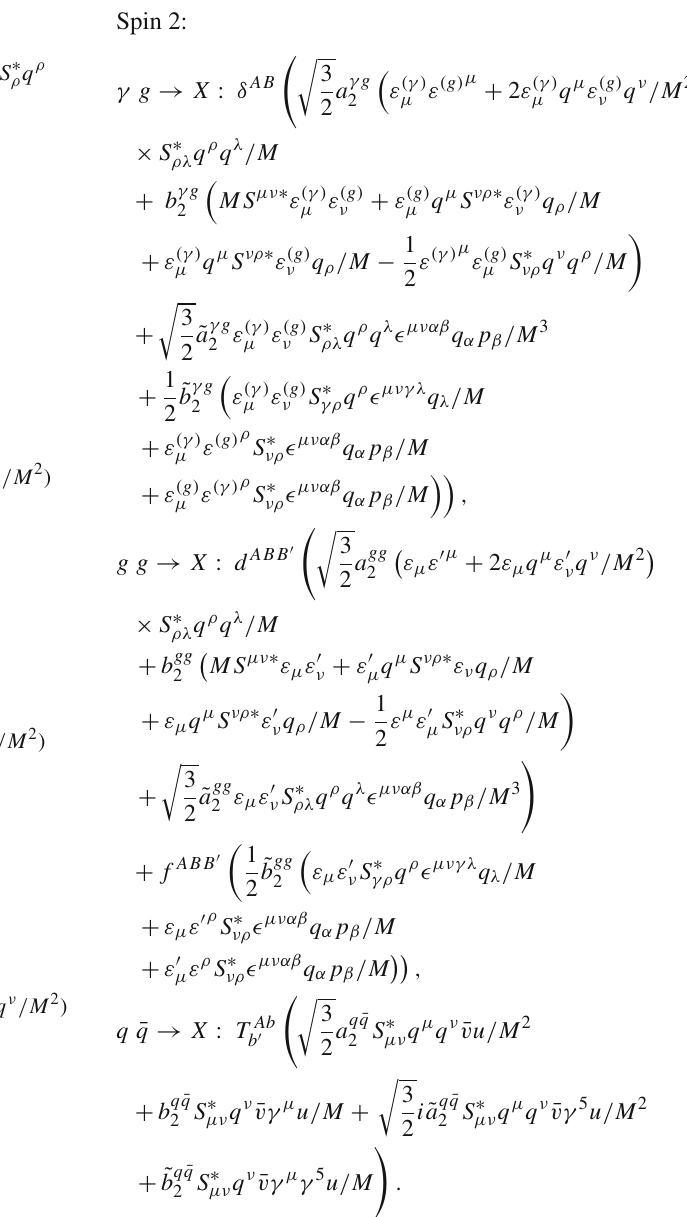
The amplitudes involving two incoming gluons respect Bose symmetry under the exchange: B ↔ B (cid:3) , ε ↔ ε (cid:3) , q ↔ − q . It is then straightforward to write down the non-zero pro- duction amplitudes out (cid:8) X , m | P , λ ; P (cid:3) , λ (cid:3) (cid:9) in for the process where parton P with helicity λ coming along the positive ˆ z axis ( θ = 0) and parton P (cid:3) with helicity λ (cid:3) coming along the negative ˆ z axis ( θ = π ) create a resonance of spin j and